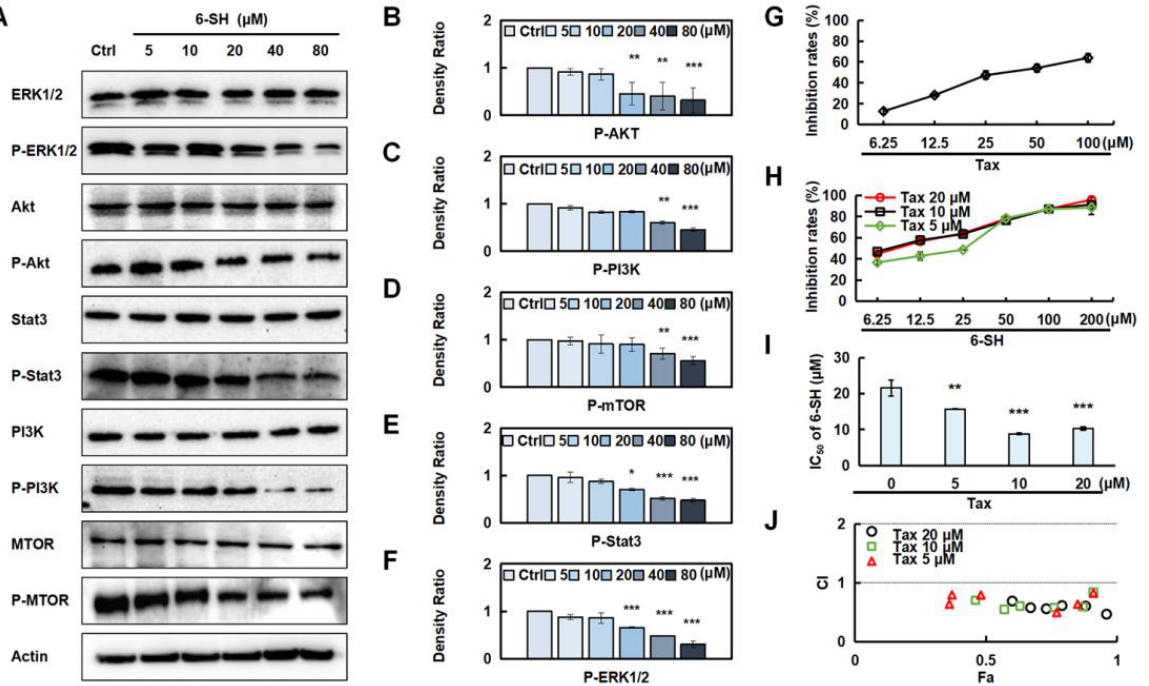
Figure 6. Validation of 6-SH anti-NSCLC pathway. ( A ) Cells were treated with 0 – 80 µM 6-SH for 24 h, and the indicated proteins were assayed. ( B – F ) Histograms show the density ratio ( n = 3). Values represent the means ± SD. * p < 0.05, ** p < 0.01, *** p < 0.001 versus “Ctrl” group. ( G – I ) Cells were treated with Tax or Tax combined with 6-SH for 72 h, respectively, the inhibition rate and IC 50 were assayed. ( J ) The CI value was calculated. CI values of <1 indicate synergistic effect. Values represent the means ± SD. * p < 0.05, ** p < 0.01, *** p < 0.001 versus “ 0 ” group.